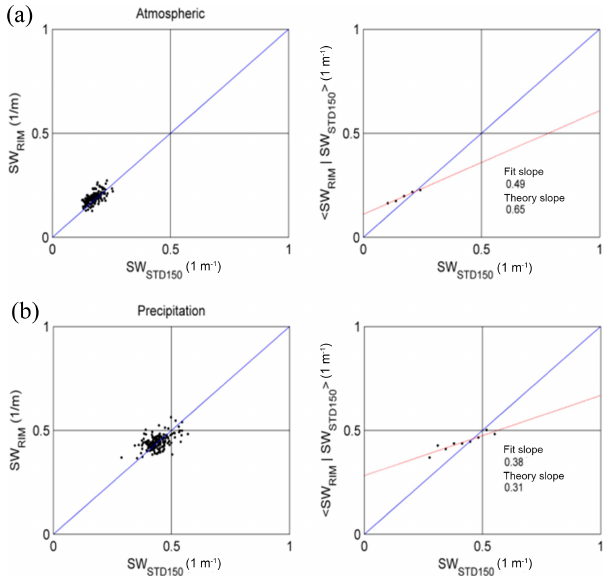
Figure 10. Results of the conditional averaging like those in Fig. 8b and c, except that spectral widths are shown (red line is the fit